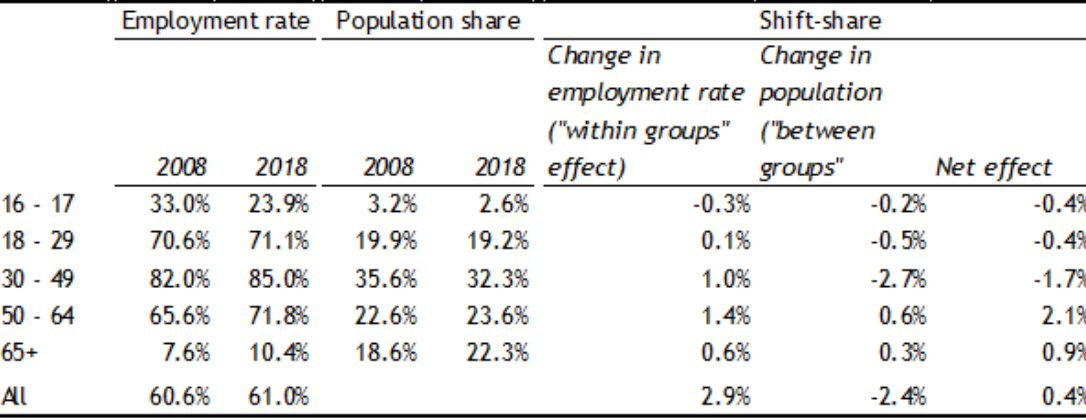
Table 5: Employment and population changes by age, 16+ year olds: 2008-18